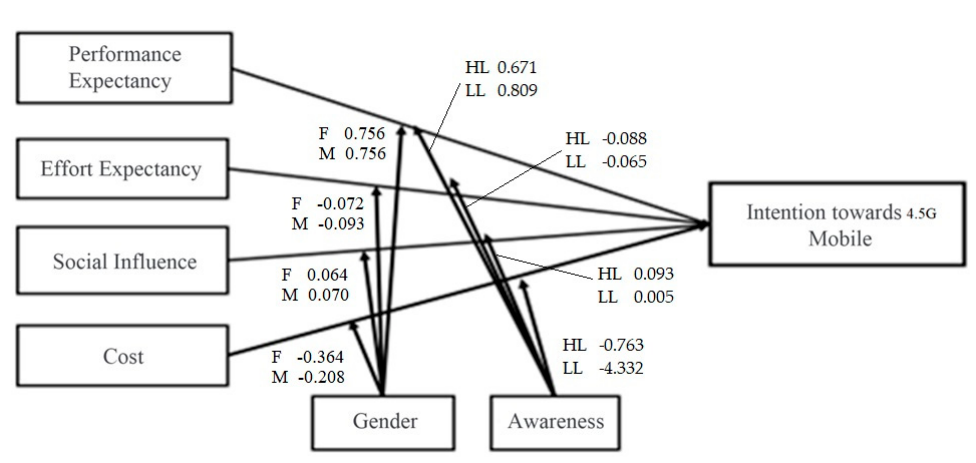
Figure 2. The structural model with the results as conceptual model.